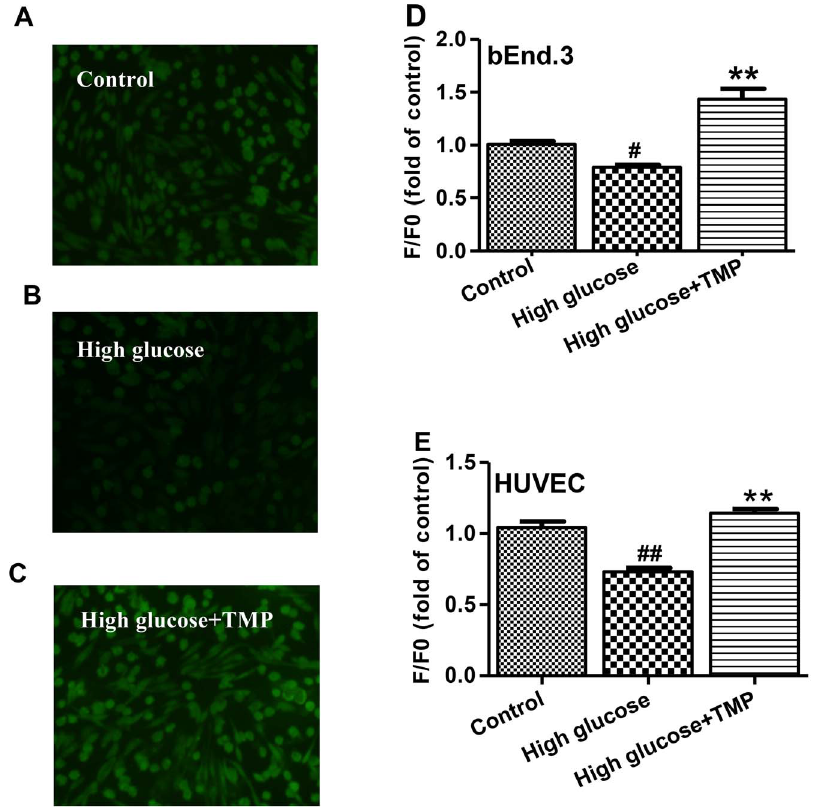
Figure 2. TMP increased NO production in endothelial cells exposed to high glucose. DAF-FM indicator was used to detect NO levels in HUVEC treated with ( A ) 5.6 mmol/L glucose (Control), ( B ) High glucose (30 mmol/L) and ( C ) High glucose + TMP (30 m mol/L). The treated cells were photographed by fluorescence microscopy ( A–C ). ( D ) bEnd.3 and ( E ) HUVEC were treated as indicated for 48 hrs, and NO production was measured using flexstation3 and quantified with the changes in fluorescence intensity. ‘‘F0’’ represents fluorescence of Control group and ‘‘F’’ depicts fluorescence of other treated groups. Data are mean 6 SEM (n=4). # P , 0.05 vs. Control; ## P , 0.01 vs. Control; * P , 0.01 vs. High glucose.